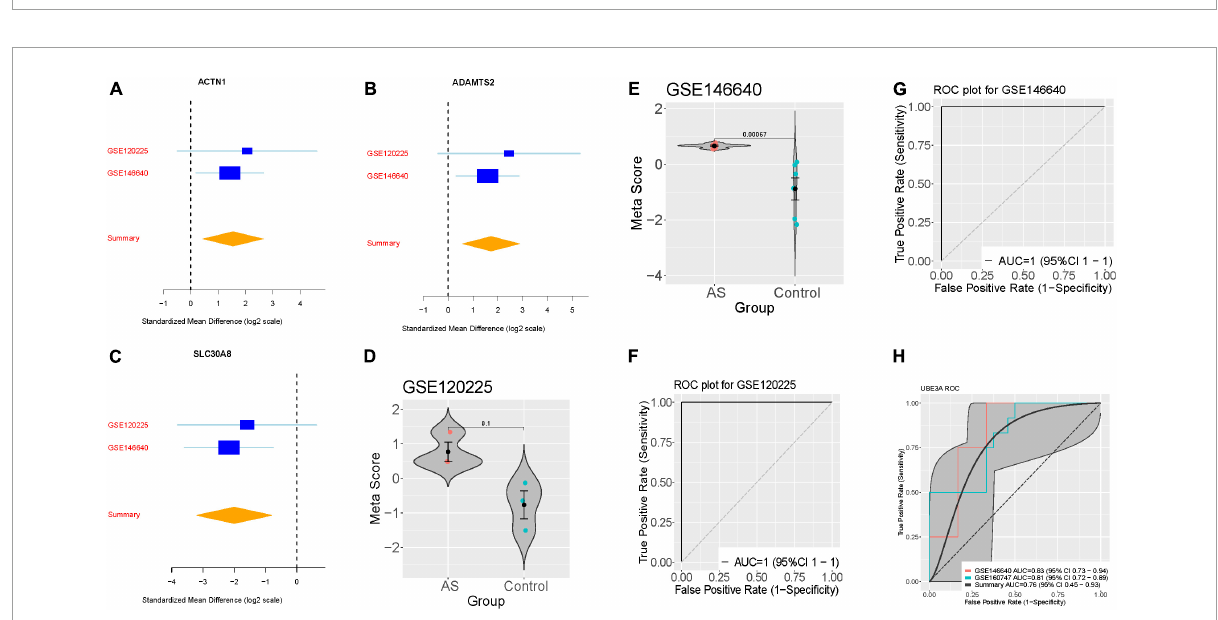
FIGURE2 Validation of three differentially expressed genes diagnosis of AS. (A–C) The up-regulated gene (ACTN1) and down-regulated genes (ADAMTS2, and SLC30A8) searches in GSE120225 and GSE146640. The x axis represents standardized mean difference between AS and dengue control. (D,E) violin plot illustrating the meta-score of the three differentially expressed genes for differentiate AS from Control in GSE120225 and GSE146640. (F,G) ROC curves of patients with AS vs. controls in GSE120225 and GSE146640. (H) ROC curves of UBE3A diagnostic power in the training and validation